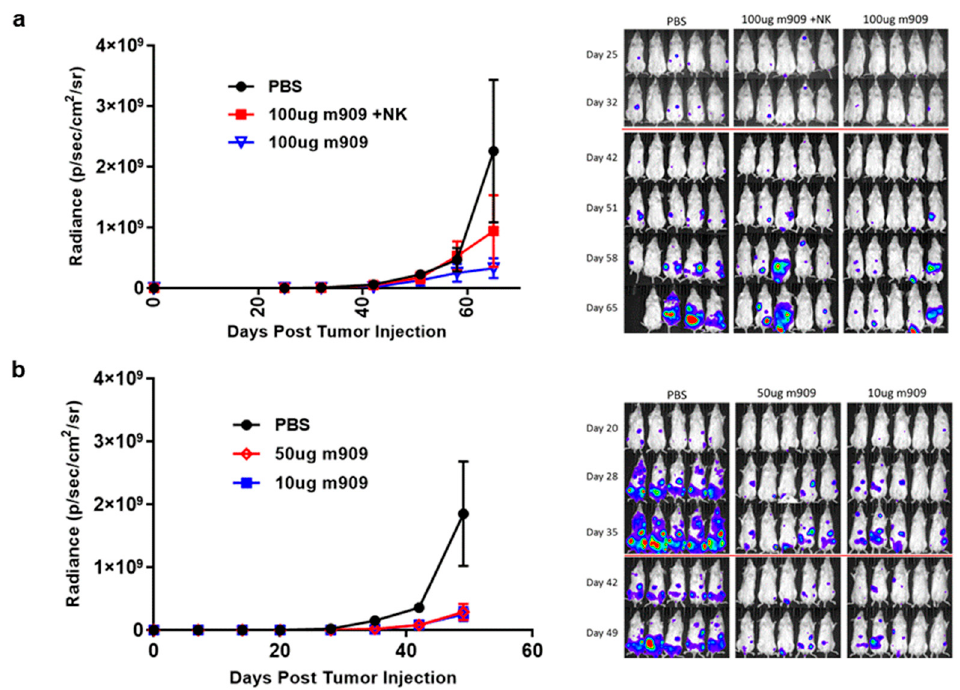
Figure 4. Preclinical activity of m909 against THP-1 tumors in vivo. ( a ) Mice were injected with 2 × 10 6 THP-1 cells expressing GFP-fLuc on day 0 and imaged weekly. They were treated with IP injection starting on day 2 every 2–3 days thereafter for 10 doses with 100 µ g m909 or PBS. The NK group received activated NK cells on day 2. The average maximum radiance of each group at each measurement time point is shown in the graph. Significant differences were identified on day 65 between the treatment groups and the PBS group. ( b ) Mice were injected with 2 × 10 6 THP-1 cells expressing GFP-fLuc on day 0 and received antibody via IP injection starting on day 2 and every 2–3 days thereafter at the respective doses for a total of 10 doses. Significant differences were identified between the treatment groups and the PBS group on day 49. All error bars represent standard error. Red lines on images indicate a change in exposure time.